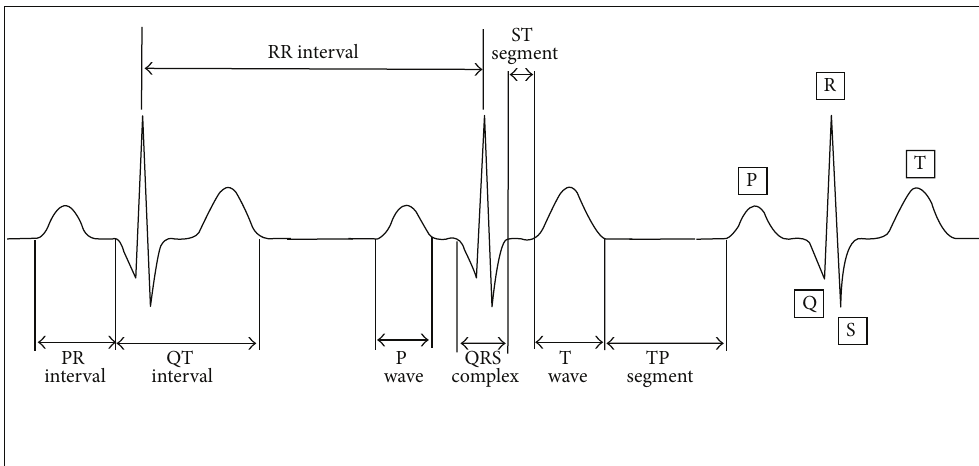
Figure 1: A typical ECG signal that includes three successive heartbeats and the information lying in the P, Q, R, S, and T waves.